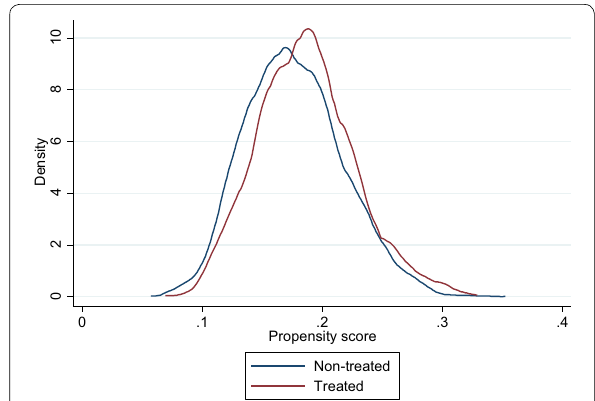
Fig. 2 Density distributions of the propensity scores for treated and non‑treated individuals. Source: COI survey 2006/INSEE‑DARES‑ CEE. Coverage: Workers aged 45–57 years old with at least 1 year of seniority and employed in firms with 20 workers or more. Note: Treated individuals are workers employed in changing firms, i.e.